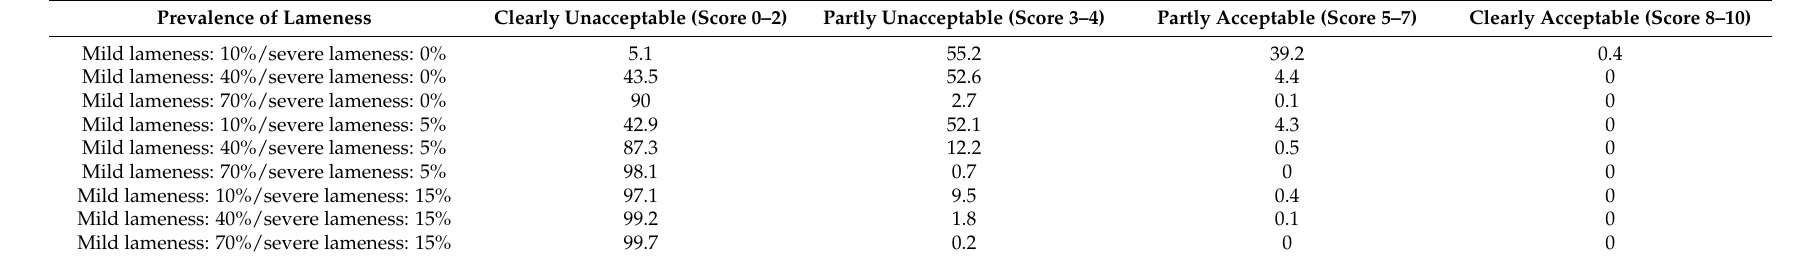
A The reported percentages are calculated predicted probabilities for an average expert based on the mixed effects